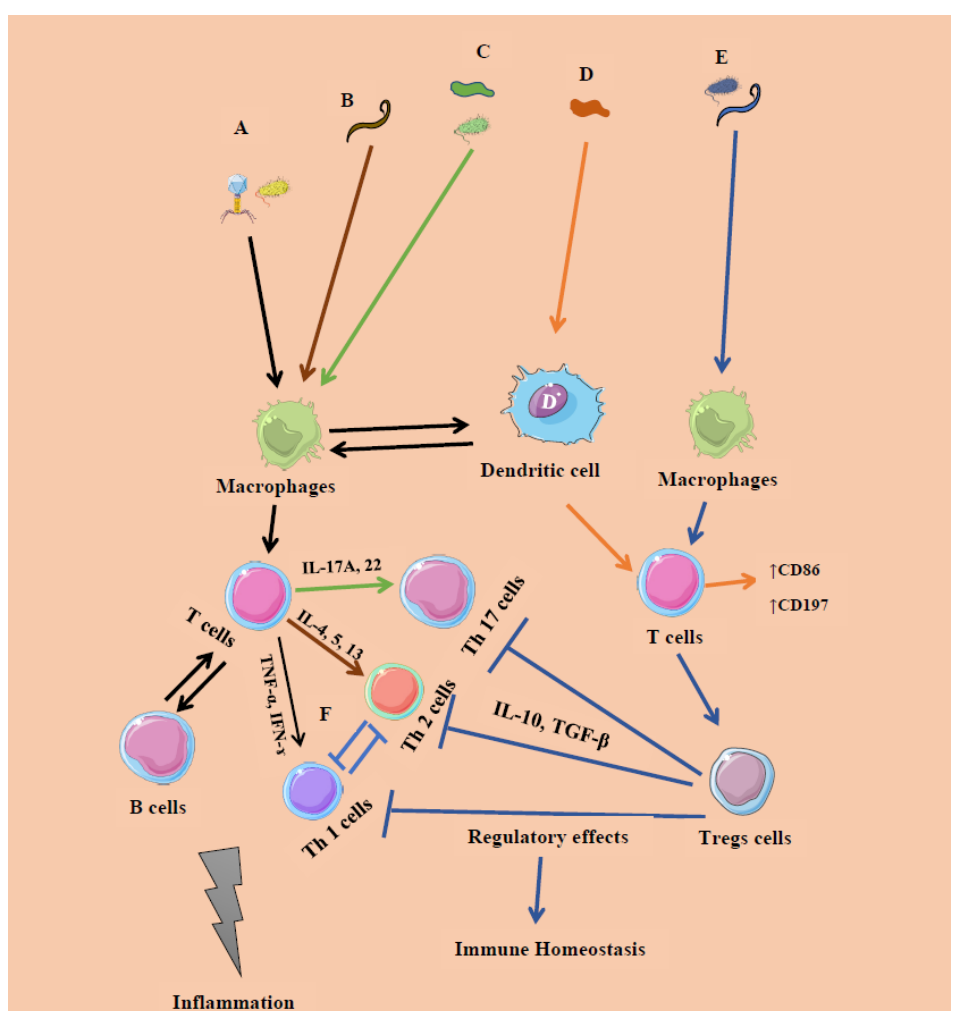
Figure 3. The known microbe – immune interactions in inflammation and homeostasis. A . Certain members of bacteria (intracellular, systemic commensals, Proteobacteria, and opportunist pathogens) and viruses induce inflammatory responses (IR 1) by promoting T cells and their subsets T helper 1 cells (Th 1) releasing pro-inflammatory cytokines such as interferon-gamma (IFN- ), tumor necrosis factor-alpha (TNF- α ), etc., initiated by microbe-associated molecular patterns ( Black arrow ). B – C . Segmented filamentous bacteria (extracellular), member of Fungi, and helminths (GATA 3) induce inflammatory responses initiated at the mucosal sites, which promote the expansion of T cells expressing Th 17 and Th 2 cells releasing Interleukins (IL) 17A, IL-22, and IFN- , respectively ( Brown and green ). D . Certain members of Archaea ( Methanomassiliicoccus luminyensis , Methanosphaera stadtmanae and M. smithii ) promote surface markers CD86, CD197 expressed on T cells releasing Monocyte-derived dendritic cells (MODC), type 1 IFN ( Orange ). All the factors involving A – D may lead to tissue damage and ultimately inflammation. E – F . Certain members of Clostridia, Bacteroides fragilis , archaea, and helminths induce regulatory responses by promoting Foxp3-expressing T regulatory (Tregs) cells, limiting the activation of Th1, Th2, and Th17 cells ( Blue ). This regulation and tolerance promote homeostasis.